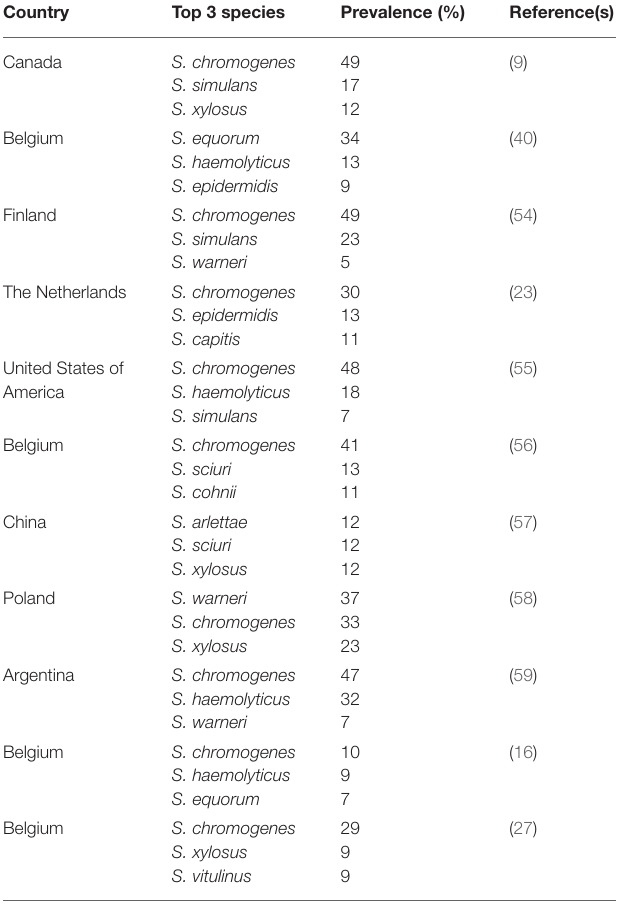
TABLE 2 | Overview of the top 3 most frequently isolated non- aureus staphylococci species in various countries from cows having subclinical or clinical